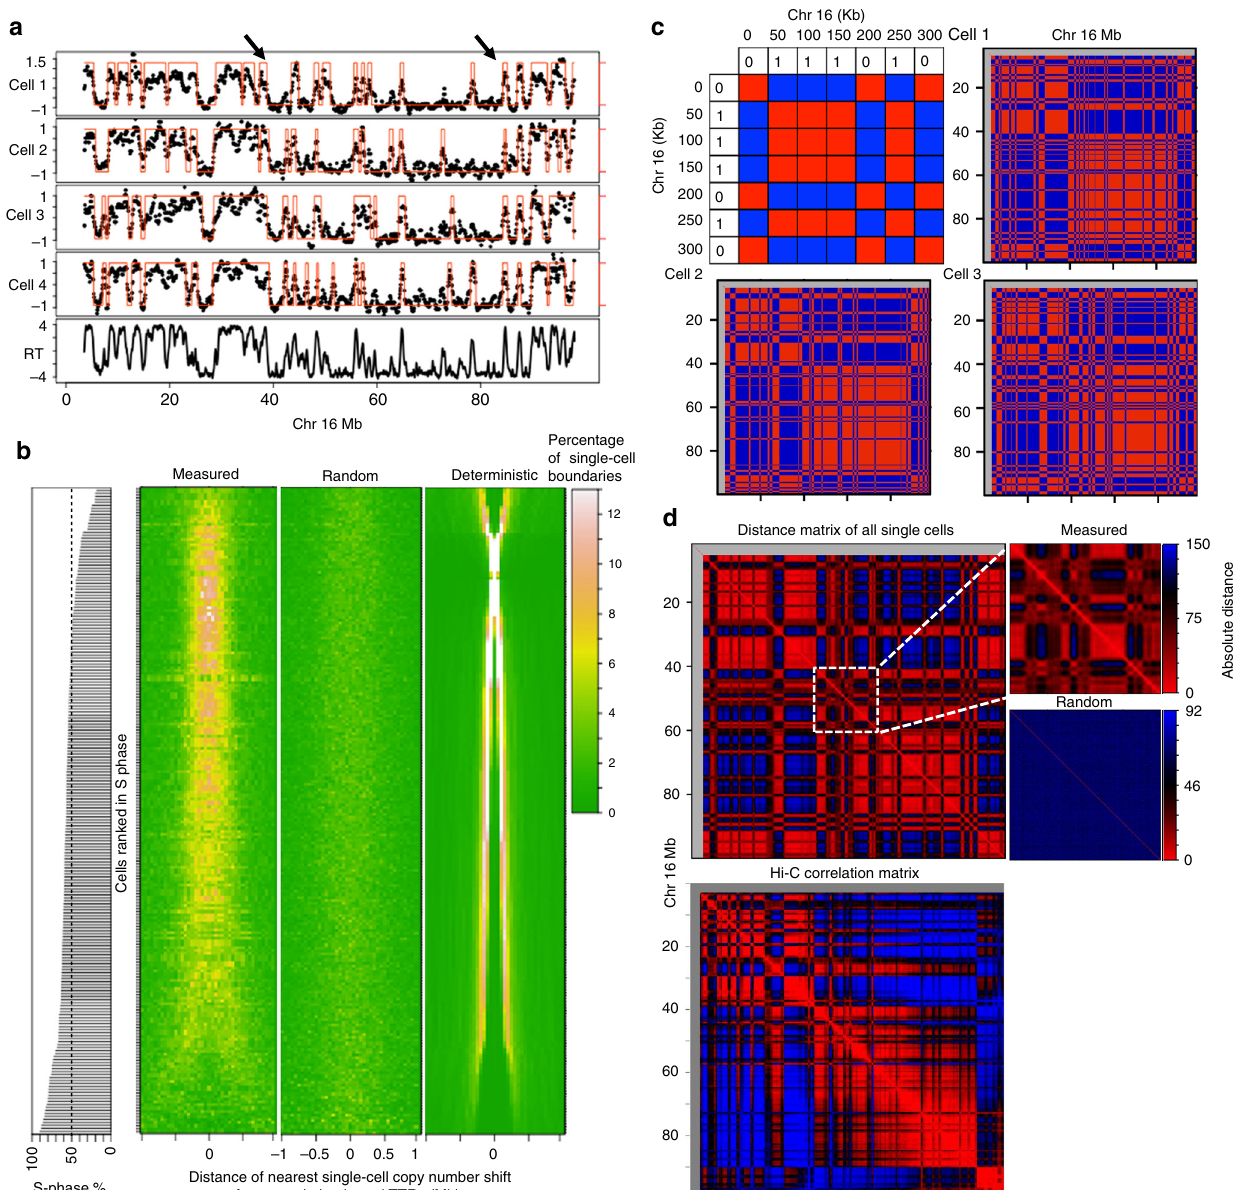
Fig. 4 Conservation of TTRs and nuclear compartments in single cells. a Binarized single-cell data overlaid on smoothed single-cell CNV pro fi les. The arrows indicate representative TTRs in population-based data that align with copy number shifts across single cells. b Heatmap showing the distance of the closest single-cell copy number shift from all population-based TTR centers. Each row represents one single-cell and the heat map shows the percentage of closest single-cell copy number shifts in that cell at different distances from the TTR center. The cells are ranked by position is S-phase. c Coordinately regulated bins in each single-cell are color coded red and oppositely regulated bins are color coded blue as shown in the top-left schematic. Whole chromosome plot of single cell from mid-S-phase shows coordinated replication across cells and align with Hi-C compartments (shown in d ). d Plotting pairwise absolute distance for all possible pairs of 50 kb bins within each chromosome, using the binary replication status across all cells reveal the functional compartmentalization of replication that show strong similarity to Hi-C compartments plotted using Juicebox 32 . The randomized control of single-cell replication lacks compartments highlighted by plotting a 20 Mb segment of Chr